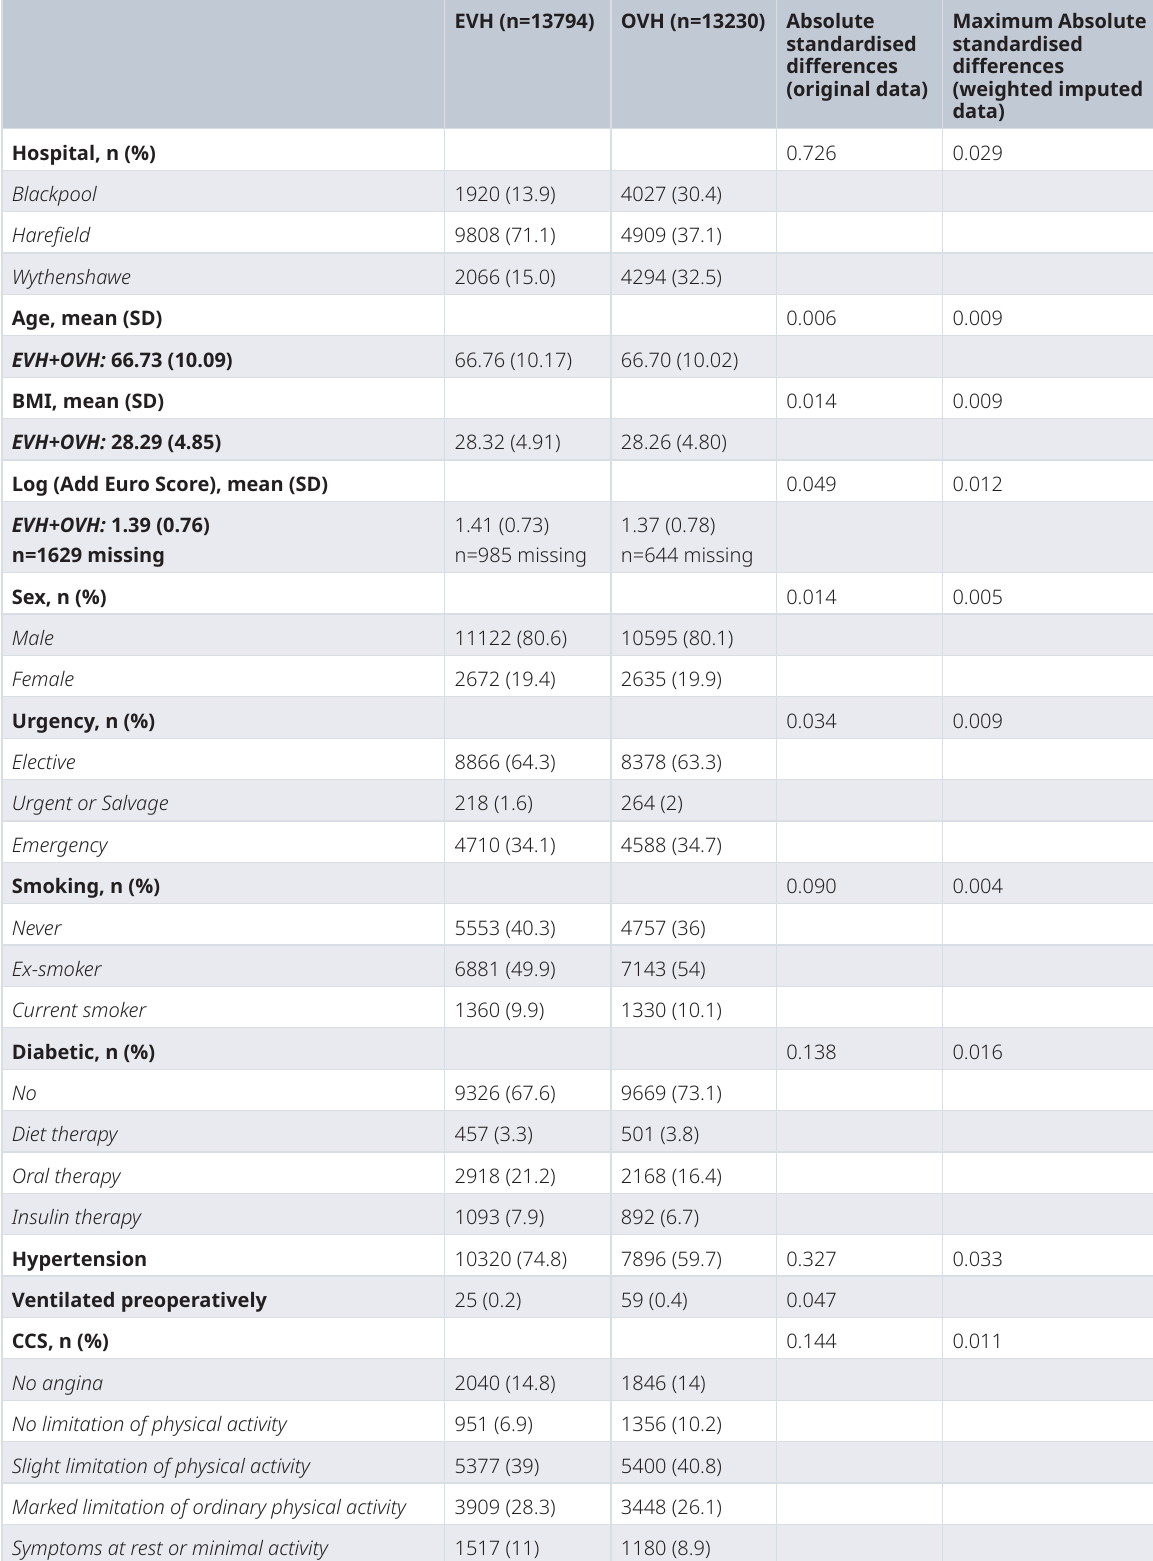
Table 1. Demographics and pre-operative